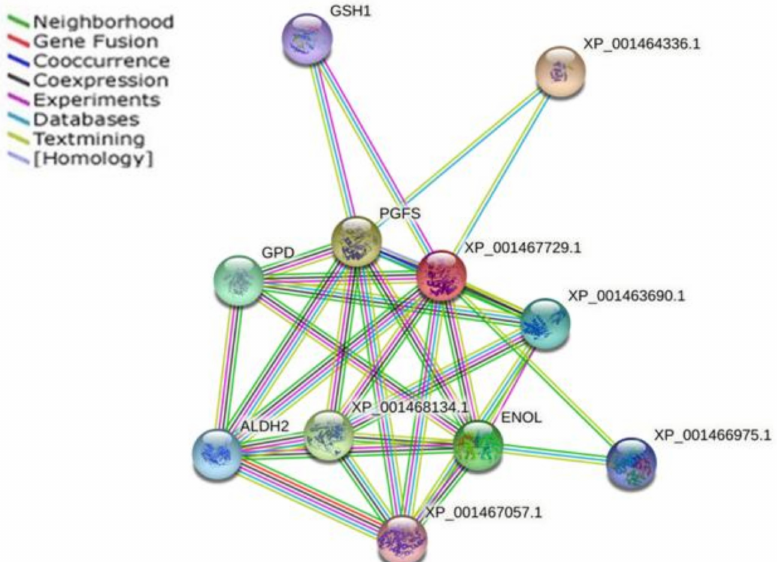
Figure 4. Functional and physical protein associations interaction map of prostaglandin F2 α synthase (PGFS). The nodes are representative of protein species, and different line colors show the types of evidence for the association. The STRING tool (http://www.string-db.org; accessed on 1 May 2022) was used to construct the interaction network. The related proteins are listed in Table 3. Table 3. List of proteins directly related to prostaglandin f synthase based on the STRING database. Protein Code